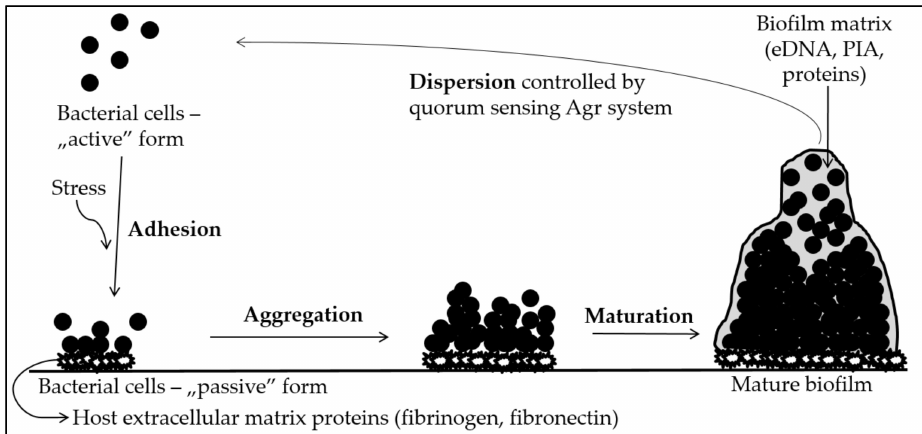
Figure 1. Stages of biofilm formation in